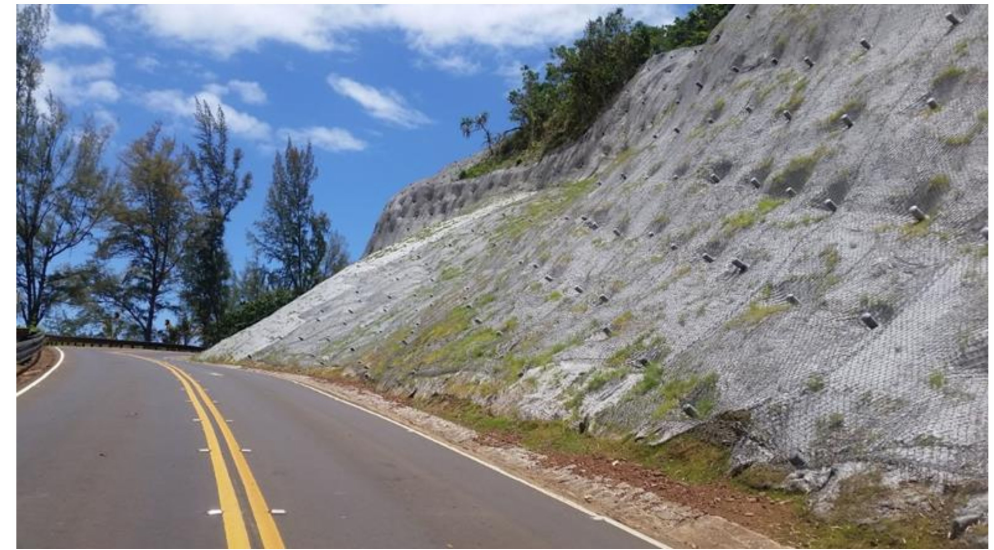
Figure 5. Conventional hillside stabilization following the landslide, Kaua’i. Source: